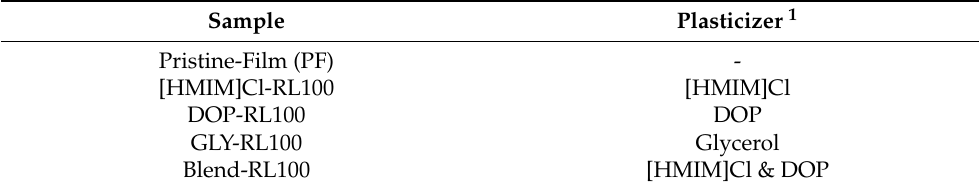
Table 1. Prior to characterization, all films were stored at room temperature and relative humidity of 25 ◦ C and 60%, respectively. Table 1. Samples prepared and